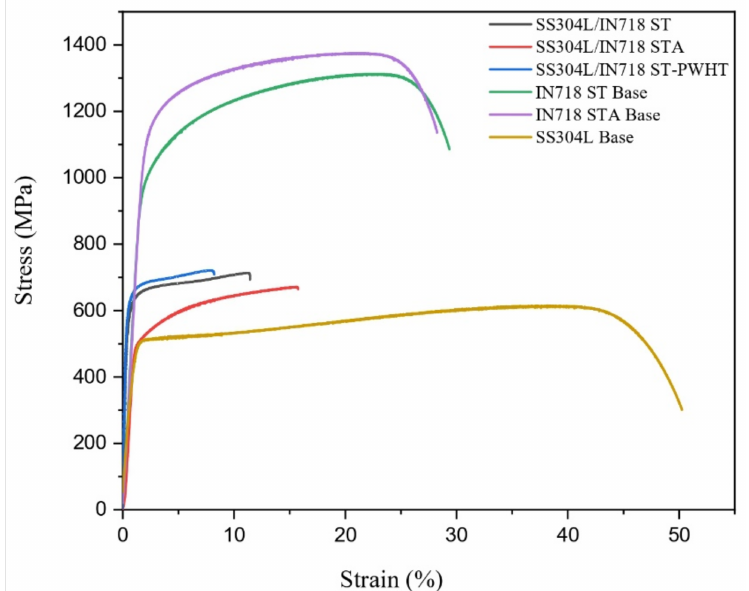
Figure 15. The typical tensile properties of the base metals and dissimilar SS304L/IN718 rotary friction welds in the as-welded ST, STA, and PWHT